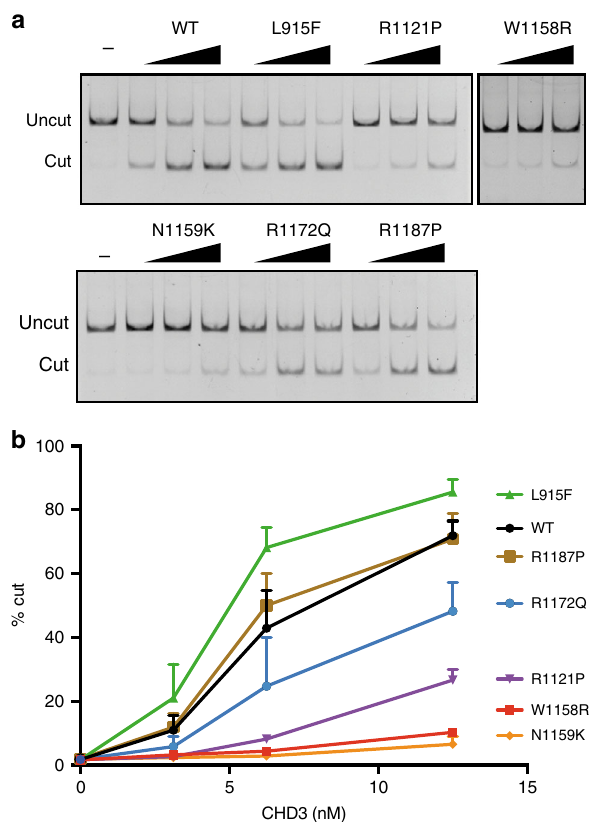
Fig. 4 Restriction enzyme accessibility assay. a Restriction enzyme accessibility analysis of CHD3 wild-type and mutant proteins. 3.125, 6.25, or 12.5 nM of CHD3 proteins were incubated with 347 bp mono- nucleosomes. Digested fragments were analyzed by native polyacrylamide gel. b Quantitative analysis of restriction enzyme accessibility. Three individual experiments from two individual puri fi cations (wild-type, p. Leu915Phe, p.Arg1121Pro, p.Asn1159Lys, p.Arg1172Gln, and p.Arg1187Pro) ( N = 6) or one puri fi cation (p.Trp1158Arg) ( N = 3) were conducted. The experimental data are presented as means with standard Taken together, with our research we identify a recognizable neurodevelopmental disorder. We de fi ne the phenotypic spec- trum associated with mutations in CHD3 , and show the effects of several different mutations on ATPase activity and chromatin remodeling capacities. Our fi ndings highlight the importance of chromatin remodeling factors, and speci fi cally the CHD3 protein, in human brain development.